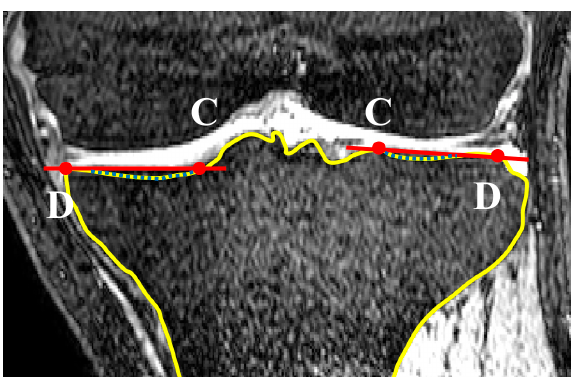
are defined based on curvature analysis (sagittal view). Bioengineering 2017 , 4 , 69